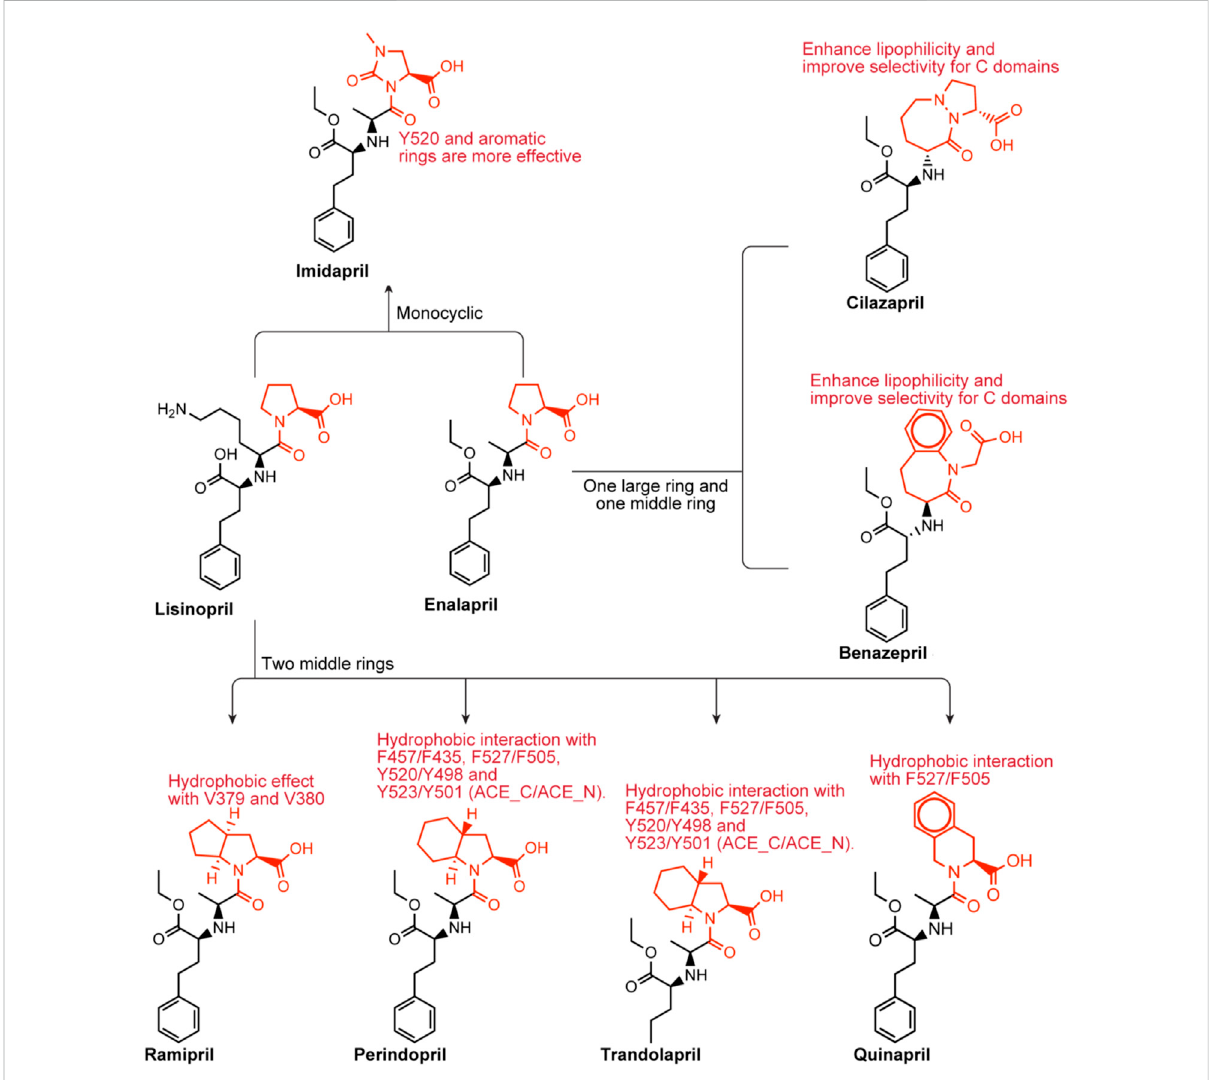
FIGURE 3 Chemical structures of dicarboxylate-containing agents. The differences of chemical structures are in